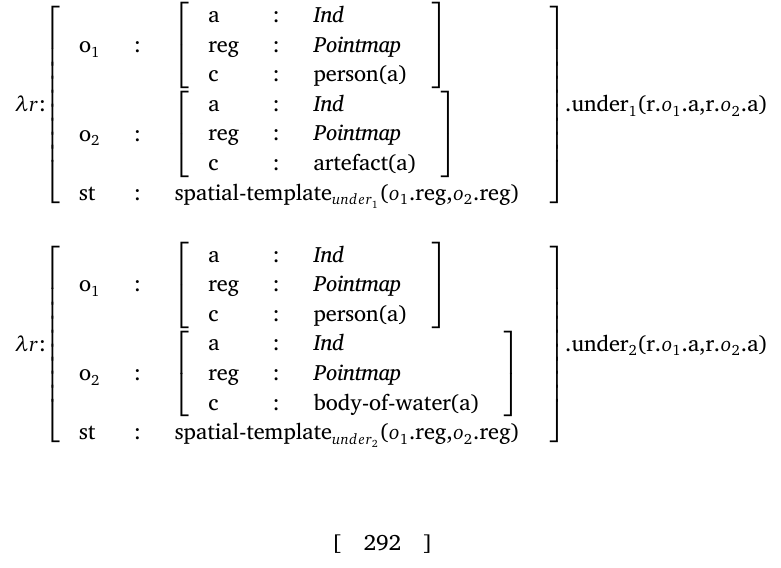
Figure 10: Spatial templates sensitive to object